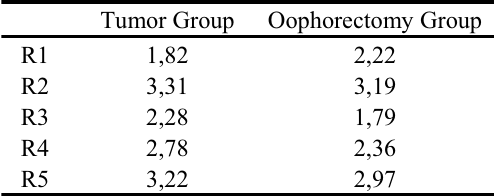
TABLE 3 - Percentage of tumor weight relative to rat body masses Tumor Group